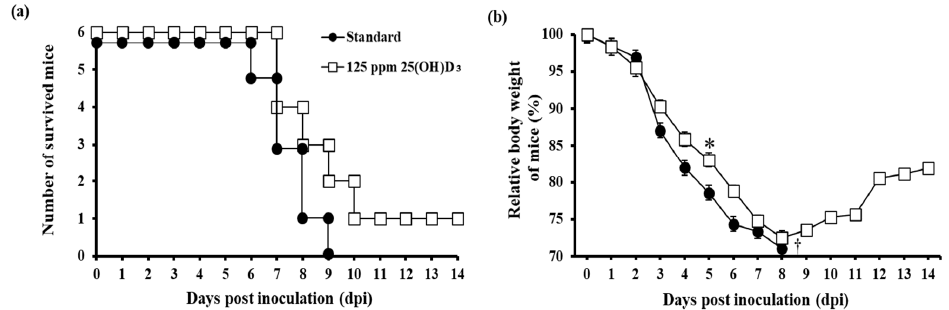
Figure 3. Survival and body weight of mice challenged with PR8 (H1N1) ( n = 6 mice / group). ( a ) Number of surviving mice over time. ( b ) Relative body weight of mice after virus challenge. *, significant difference ( p < 0.05); †, all mice deceased.